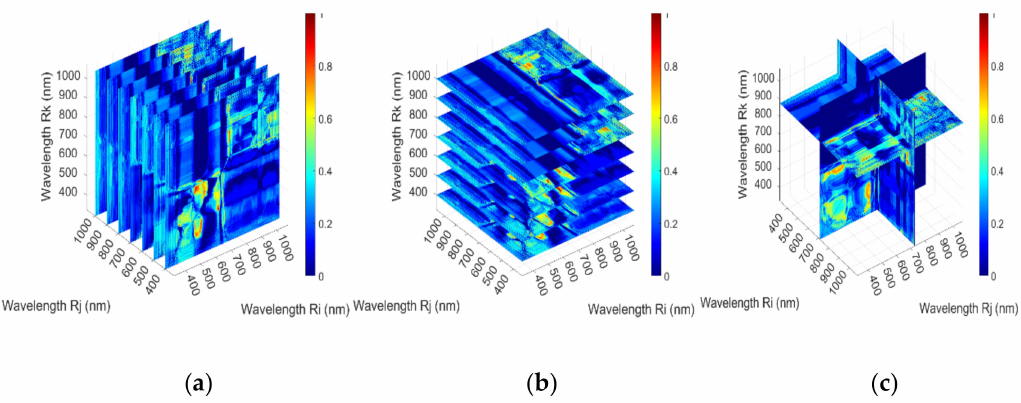
Figure 4. The 3D KI slice map of the ideal sequence and damage level sequence on RIRSI. ( a ) Vertical slice, ( b ) horizontal slice, ( c ) best slice.